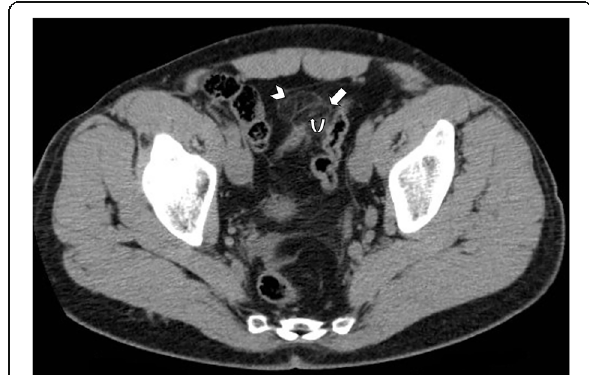
Fig. 5 Acute epiploic appendagitis in a 40-year-old man. Axial non- contrast CT image demonstrates a fatty ovoid lesion with high density rim (arrow) that abuts the sigmoid colon and contain central focal area of hyperattenuation (curved arrow), consistent with the “ central dot sign ” suggestive of thrombosed vascular pedicle. Note also surrounding mild fat inflammation